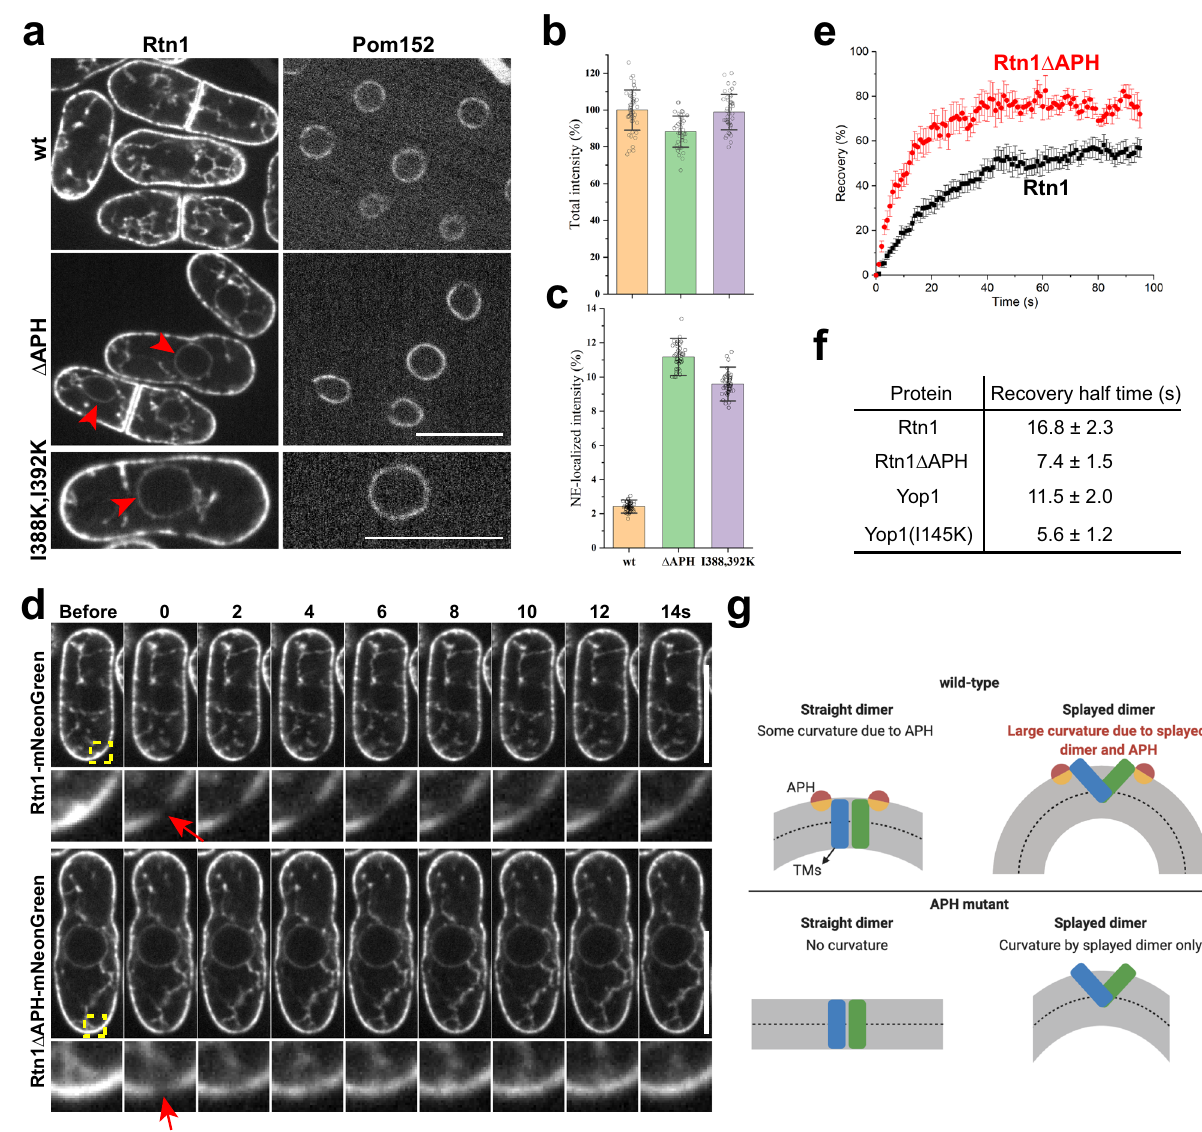
Fig. 8 The APH is required for Rtn1 ’ s exclusive ER-tubule localization and restricted mobility in S. japonicus cells. a Fusions of mNeonGreen with wild- type Rtn1 or APH mutants ( Δ APH, and I388K, I392K) were expressed in S. japonicus cells under rtn1 ’ s native promoter. The cells also expressed a mCherry- fusion of Pom152 as a marker for nuclear pores and the nuclear envelope (NE). The cells were visualized with a confocal fl uorescence microscope. Shown are representative images focused on the center of the cells obtained from three independent experiments. Arrowheads point to NE-localized mutant Rtn1. b Quanti fi cation of total fl uorescence intensity. Background fl uorescence acquired from untagged cells was subtracted. The total fl uorescence of the mutants was normalized to that of wild-type cells. c Quanti fi cation of NE-localized fl uorescence intensity. The Rtn1 fl uorescence co-localizing with Pom152 was determined, the cytoplasmic background was subtracted, and the difference divided by the total intensity. Data are presented as mean ± SD of n = 49 (wt), 43 ( Δ APH), and 46 (I388K, I392K) cells for each strain from two independent experiments. d Cells expressing Rtn1-mNeonGreen or Rtn1 Δ APH- mNeonGreen were bleached at their periphery and the recovery of fl uorescence followed over time (FRAP). The box shows the bleached area. The lower panels show magni fi ed views. The arrows point to the bleached region of the peripheral ER. Bars, 10 µ m. e Quanti fi cation of FRAP experiments. Fluorescence intensity before and immediately after bleaching was set to 100% and 0%, respectively. Error bars are standard error of the mean (SEM) of each time point from nine Rtn1-mNeonGreen-expressing cells and ten Rtn1 Δ APH-mNeonGreen-expressing cells. f Recovery half-times (± SEM) were calculated from FRAP experiments, such as shown in d . The analysis for Rtn1, Rtn1 Δ APH, Yop1, and Yop1 (I145K) is based on 9, 10, 14, 11 cells from three independent experiments, respectively. g Model for membrane curvature generation by REEP dimers. The TMs of REEPs can form either straight dimers (monomers represented by green and blue rods) that span the lipid bilayer (gray) or splayed dimers that sit predominantly in the outer lea fl et of the bilayer. The APH (red/orange circle) promotes the formation of splayed dimers by generating local curvature through hydrophobic insertion. APH mutants can still generate membrane curvature when their local concentration is suf fi ciently